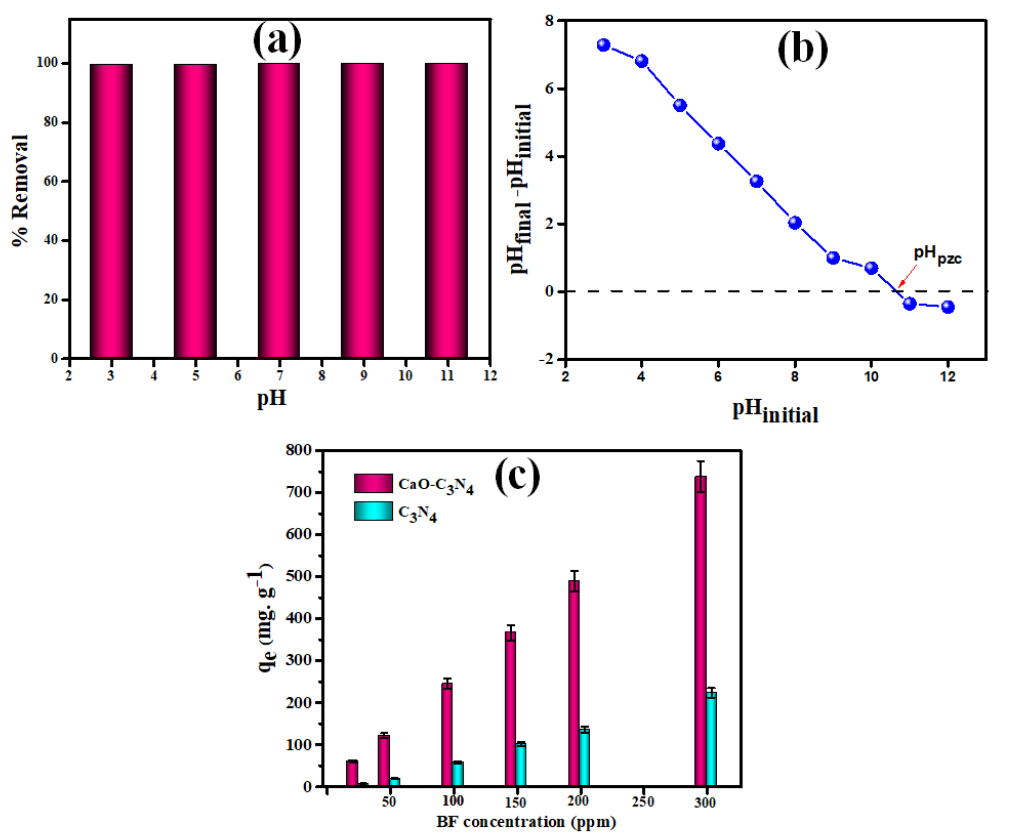
Figure 6. ( a ) Effect of pH on % removal of BF, ( b ) plot for the determination of pH pzc for CaO-g-C 3 N 4 nanosorbent, and ( c ) influence of dye concentration onto the adsorption capacity of CaO-g-C 3 N 4 and g-C 3 N 4 nanosorbent.